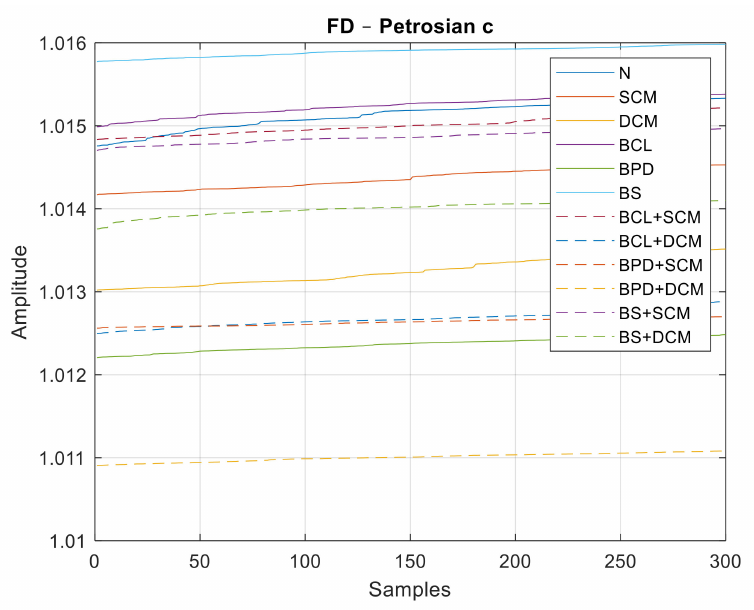
Figure 29. FD values for the Petrosian c